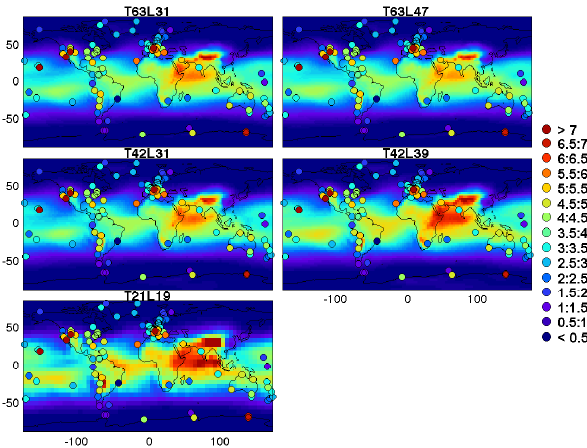
Fig. 2. 1998–2002 mean surface air concentration of 7 Be (mBq m − 3 STP) with different model resolutions. The dots show the location and observed concentration of the measurement stations (references given in the text).